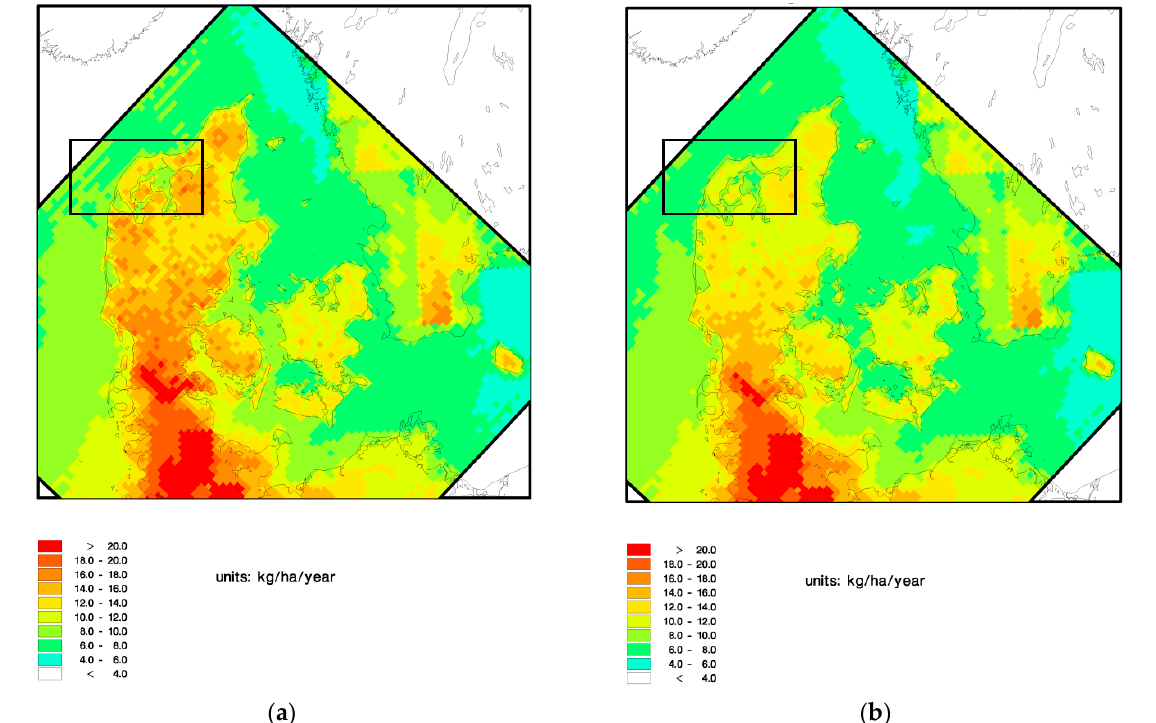
Figure 3. The modeled total deposition of Nr in the baseline ( a ) and the scenario ( b ) runs. From the 5.56 km × 5.56 km inner nest of the DEHM model. The Limfjord area is indicated by the black box. Table 4. The modeled annual depositions of NOx and NHx (wet and dry) into the Limfjord catchment area and to the marine areas of the Limfjord in the two simulations. The total deposition and the change between the baseline and the scenario are also given.